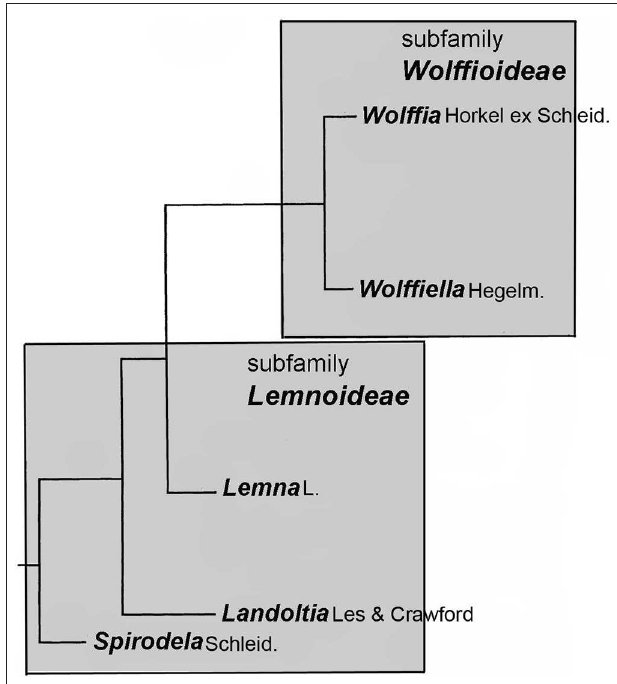
FIGURE 1 | Structure of the family Lemnaceae in relation to genera. The presentation is related to the sequence data of Tippery et al. (2015).